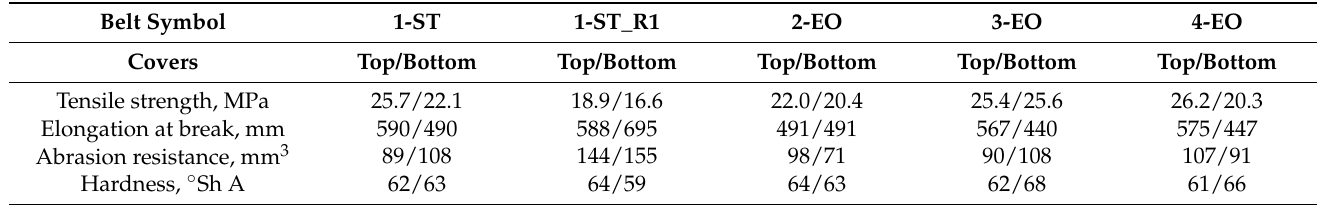
Table 1. Physical and mechanical parameters of the rubber covers.